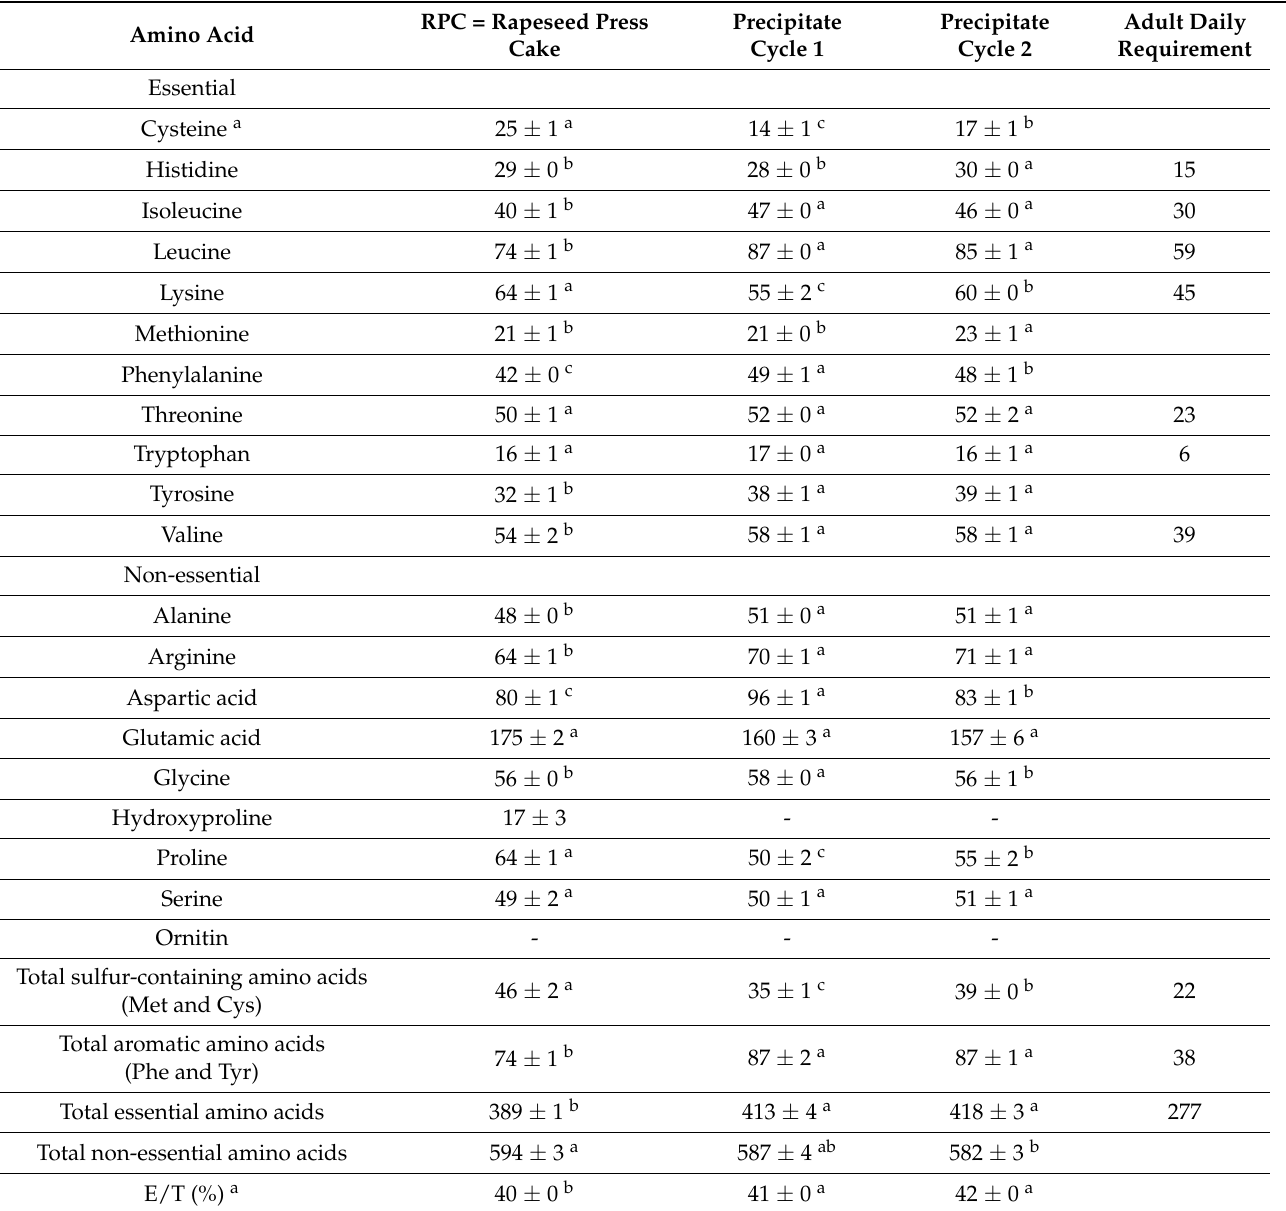
Table 3. The amino acid profile is expressed as mg indispensable amino acid per g protein. The amino acid profile of the rapeseed press cake and the precipitate from the first and second cycle are shown in the table. Additionally, the daily requirements (mg/g) for an adult according to FAO/WHO/UNU (2007) [47] are presented in the table. Dash (-) indicates that the amino acid concentration was below the detection level of the method used. Different letters indicate significant differences, p ≤